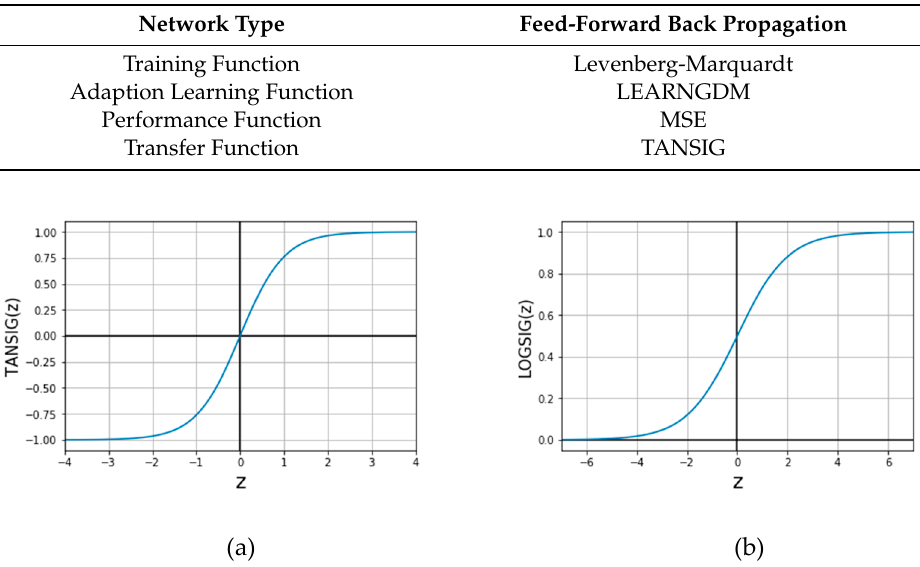
Table 3. Neural Network characteristics.